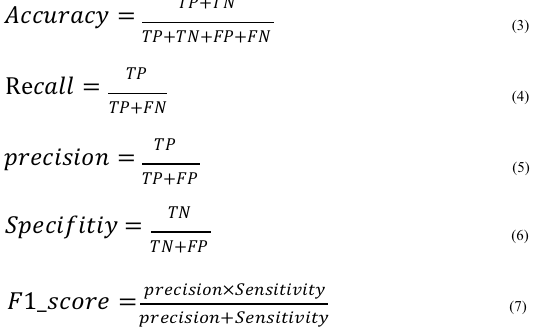
COVID Fig. 3. CNN architecture used